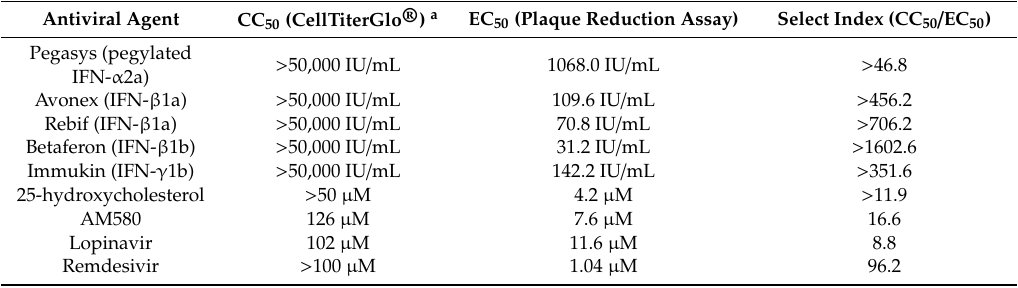
Table 2. Antiviral activities and cytotoxicities of the anti-SARS-CoV-2 antiviral agents identified in the primary screening.